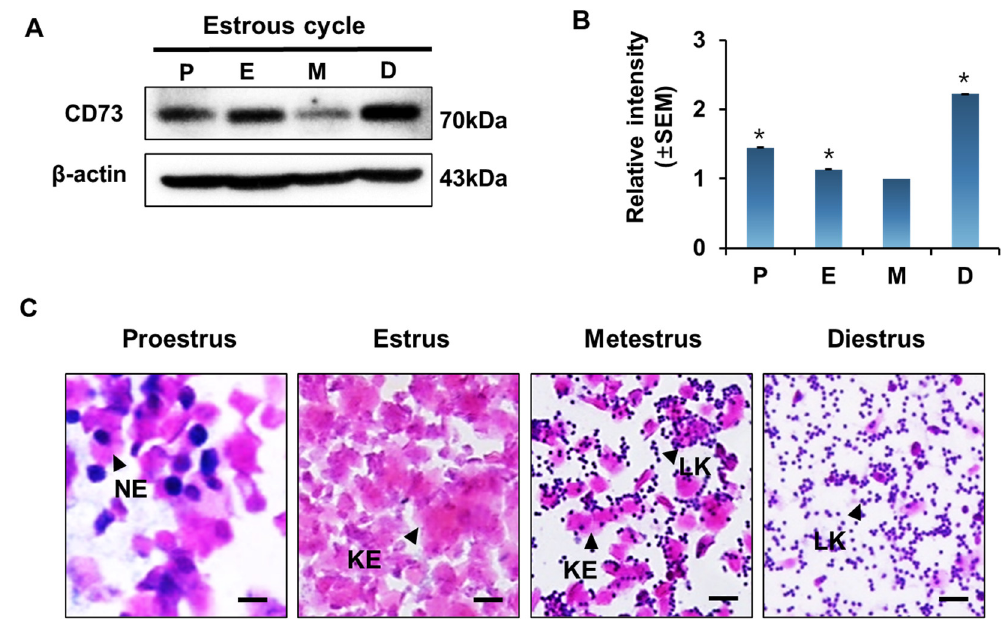
Figure 1. CD73 expression in the mouse uterus during estrous cycle. ( A ) Western blot analysis of CD73 in mouse uterus at each stage during estrous cycle ( n = 4). β-actin antibody was used for loading control. P, proestrus; E, estrus; M, metestrus; D, diestrus. ( B ) Relative levels of CD73 in uterus from different stages of estrous cycle. Each value is expressed as a relative value based on metestrus stage of estrous cycle. Data are shown with mean ± SEM. The one-way ANOVA analysis was used to calculate p -value, * p -value < 0.01. ( C ) Vaginal smear assay was performed to confirm the estrous cycle. NE, nucleated epithelial cell; KE, anucleated keratinized epithelial cell; LK, leukocyte. The black scale bars indicate 50 µm.